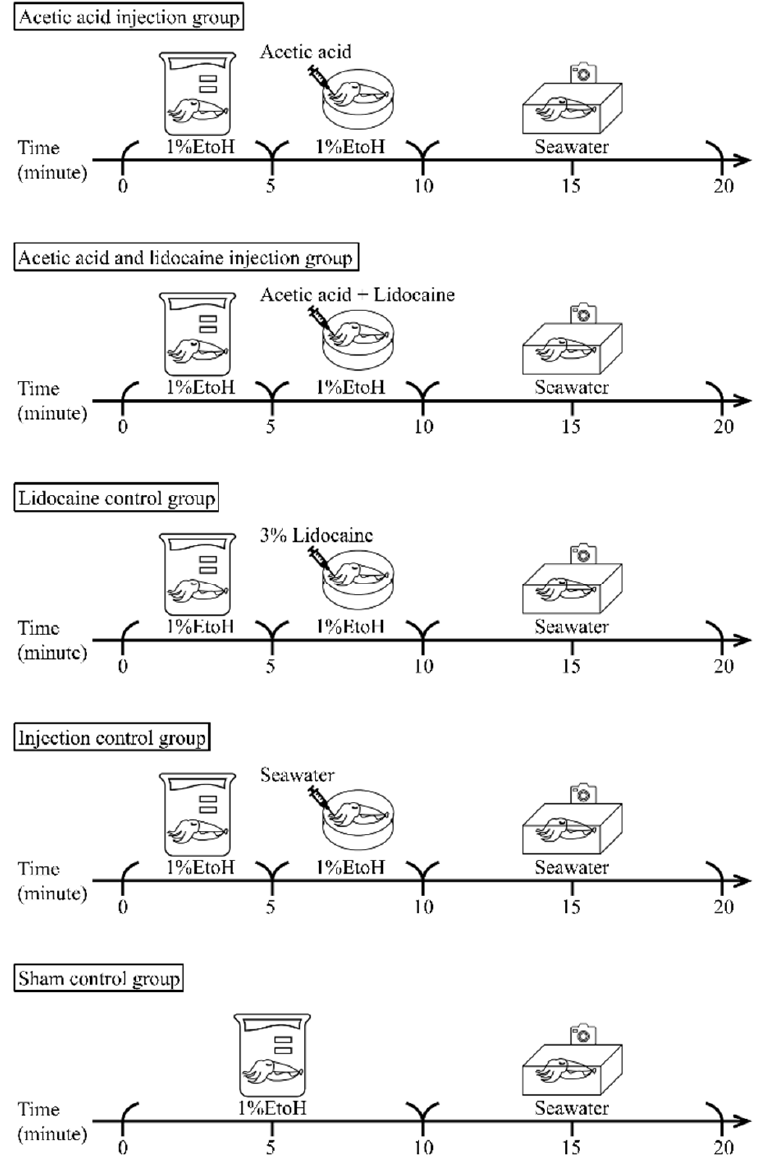
Figure 2. A schematic showing the experimental design.